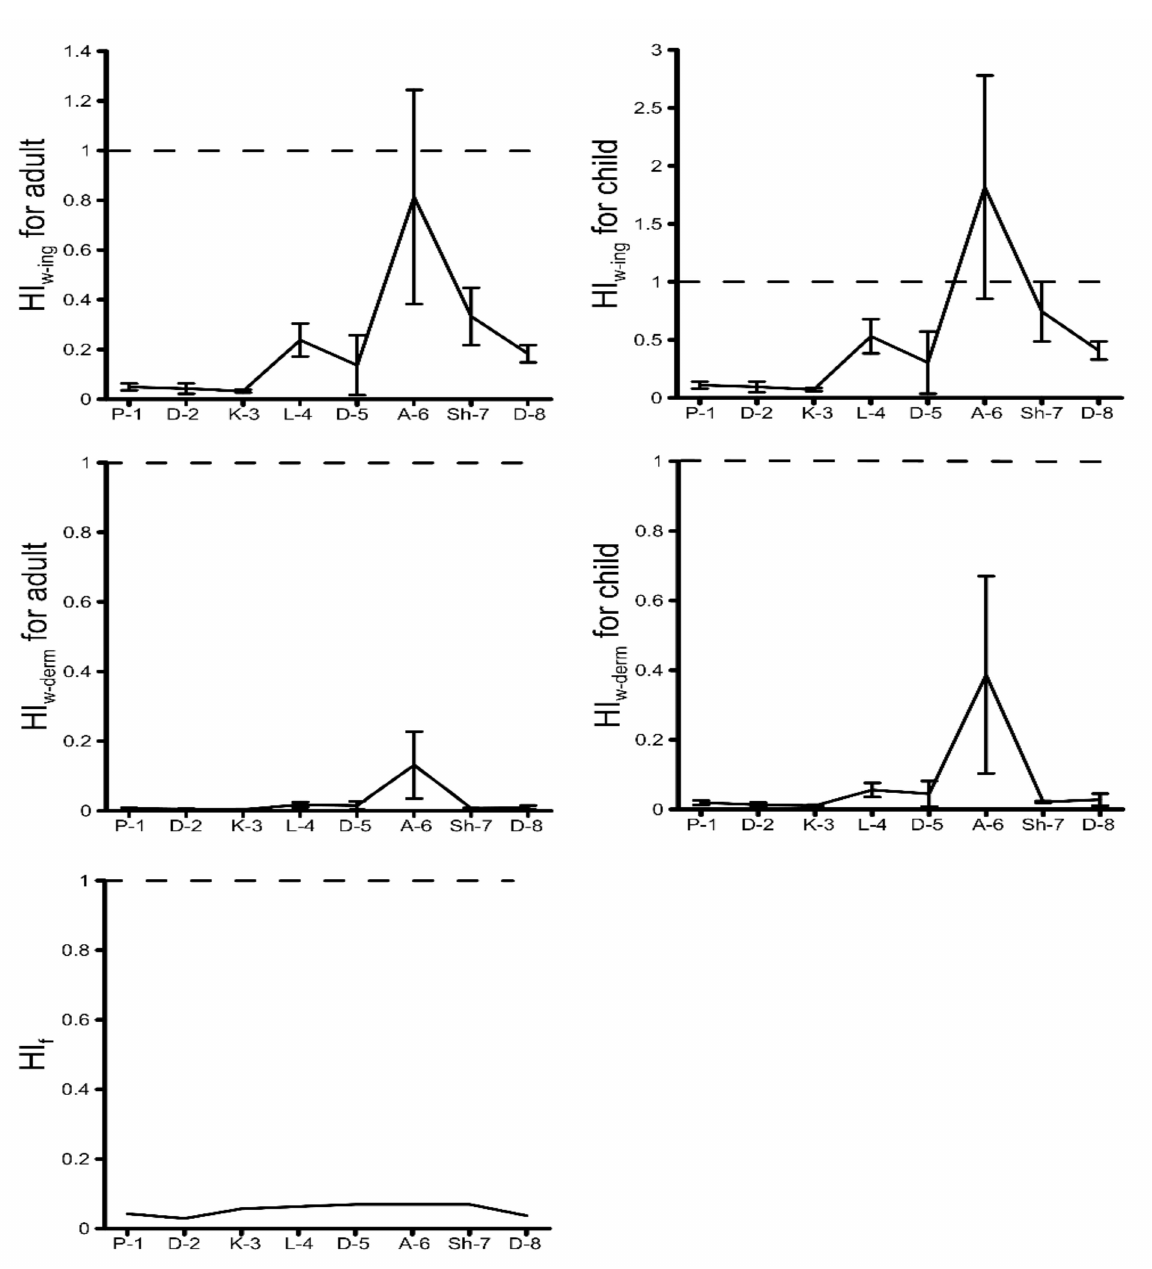
Figure 3. Hazard index (HI) of HMs in the river waters and fish of the Debed catchment